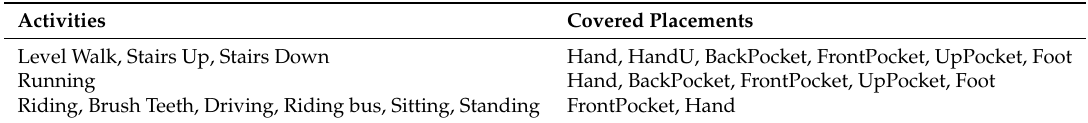
Table 4. Mounted placements of activities in data collection.